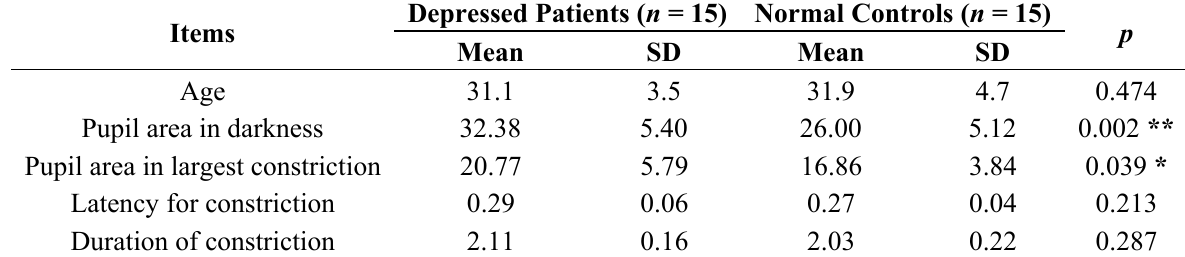
Table 1. Mean and standard deviation of pupillary variables in depressed patients and normal